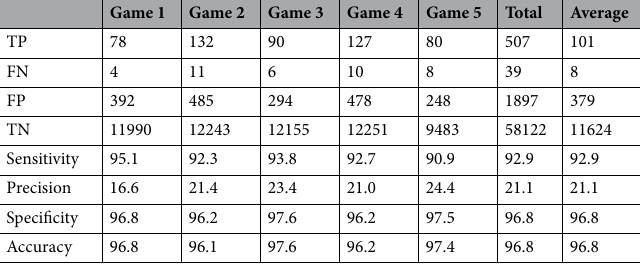
Table 4. Header detection performance on the test games.